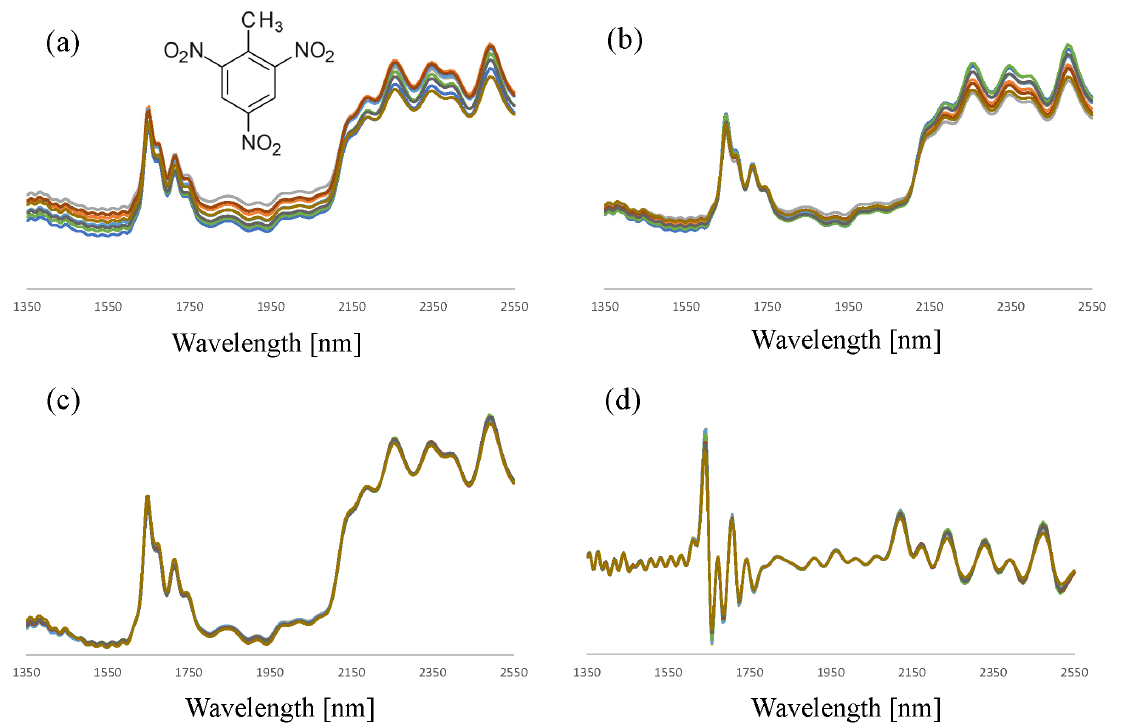
Figure 3. NIR spectra (n = 10, 2 samples) of TNT as measured with the NIR analyzer ( a ) and after sum normalization ( b ), SNV ( c ), and taking the first derivative ( d ) of the absorbance.